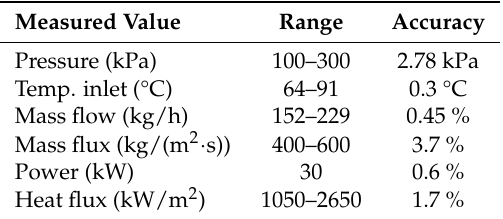
Table 4. Accuracy of measurement